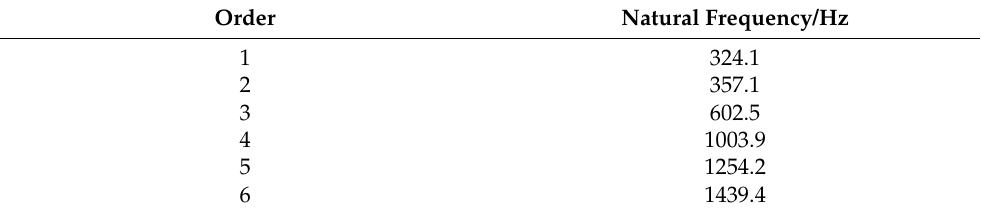
Table 1. Natural frequency of the first six modes of control arm.